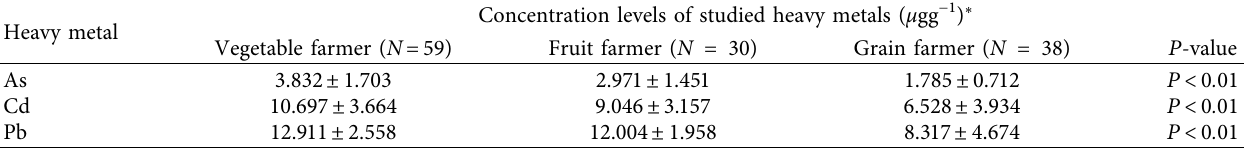
Table 9: Concentrations of Cd, Pb, and As in fingernails of farmers in various plantation groups.